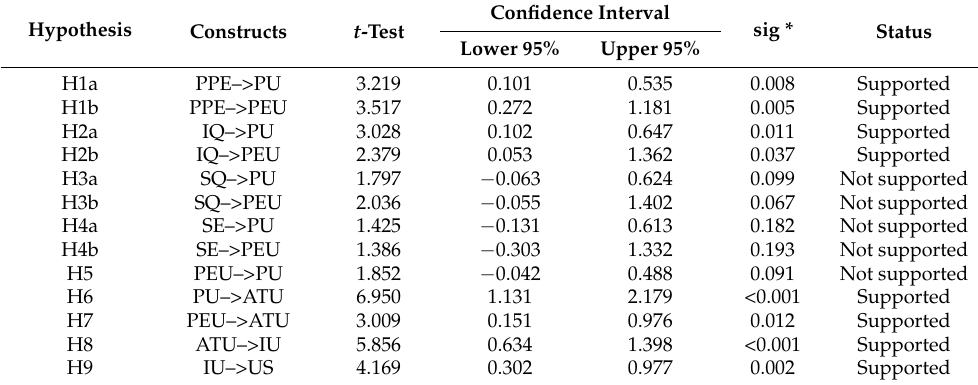
Table 2. Regression analysis result of Moodle survey.